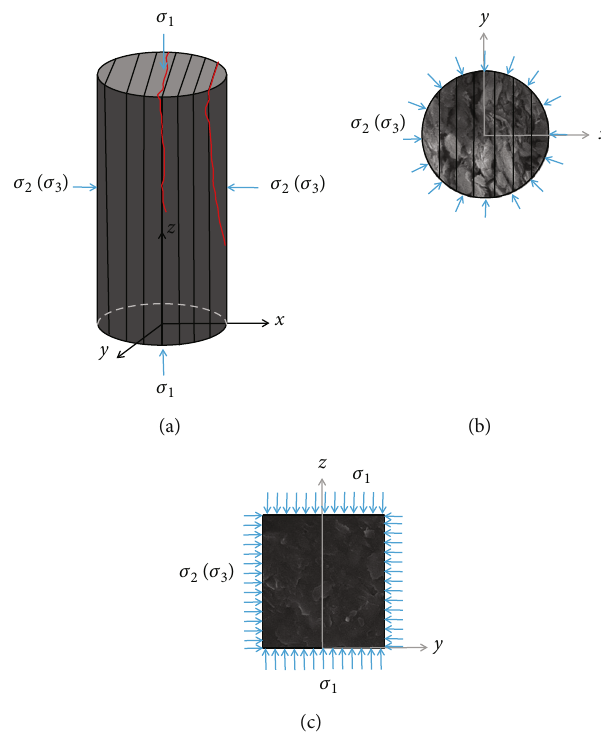
Figure 5: The core with the pressures in orthogonal coordinates.